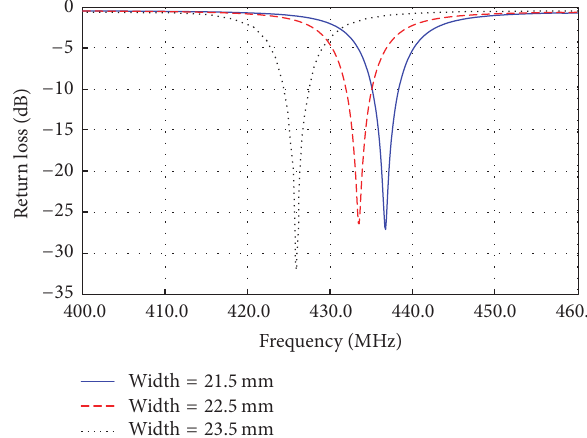
Figure 7: Simulated return losses of the proposed antenna with variations of the capacitive strip width 𝑊 𝑠